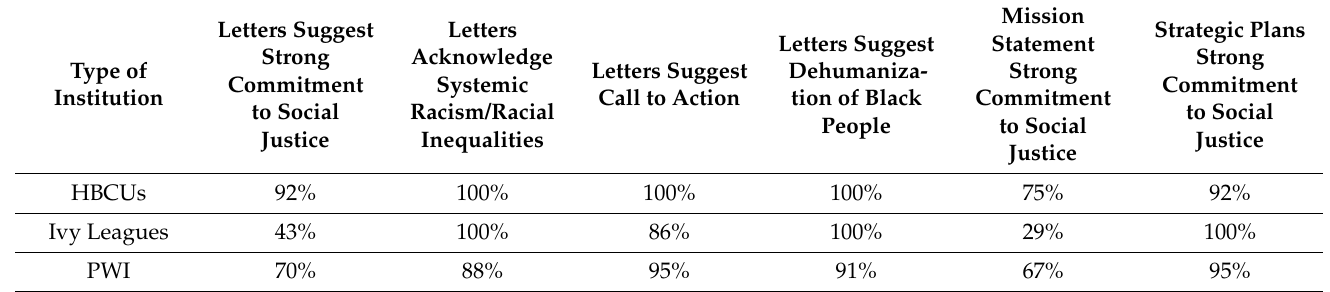
Table 4. Comparison of themes in letters to results from mission statements and strategic